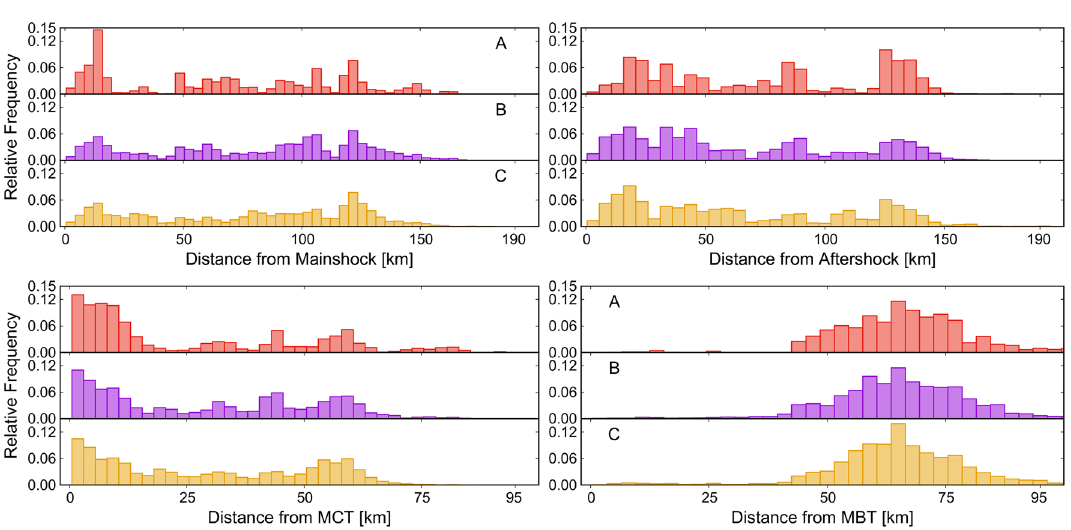
Figure 6. Relative frequency of landslides distance from the mainshock epicenter (top row, left column), from the aftershock epicenter (top row, right column), the main central thrust (bottom row, left column) and from the main boundary thrust (bottom row, right column). Plots correspond to the larger extent of the three bigger inventories considered in this work ( cf. Figure objective of mapping. The dense cluster of landslides near the main central thrust (MCT) implies that the thrust system near the epicenter (here, MCT) is highly prone to landslides. This is supported by the studies conducted by Nepal et al. 62 and Shrestha et al. 63.